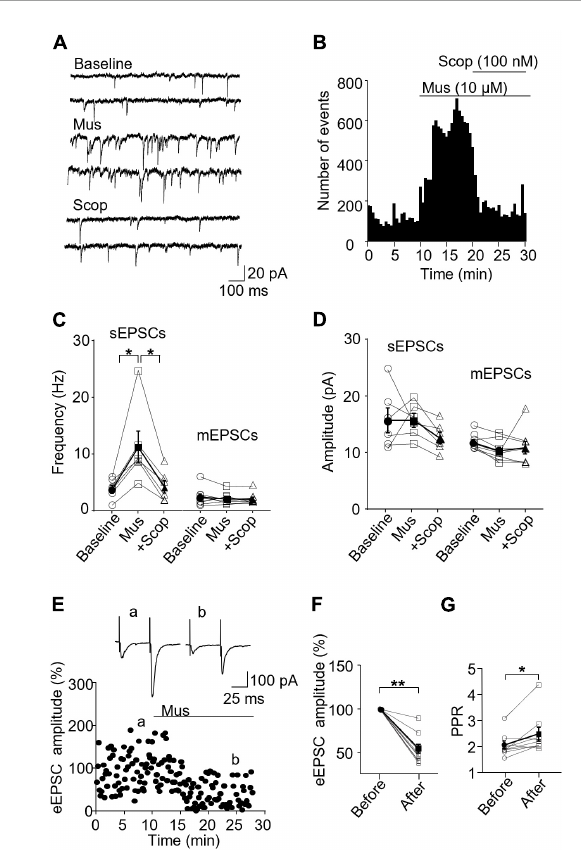
FIGURE2 Activation of mAChRs enhances spontaneous excitatory synaptic activity in SST interneurons in the ACC. (A) Representative traces of sEPSCs from an SST interneuron in the ACC before and after application of muscarine (Mus, 10 µ M) and subsequent addition of scopolamine (Scop, 100 nM). (B) A histogram from an SST interneuron shows the effect of bath application of muscarine and subsequent addition of scopolamine on sEPSC frequency. (C,D) Summarized data show the effect of muscarine on sEPSC ( n = 6 cells/6 mice) and mEPSC ( n = 6 cells/3 mice) frequency and amplitude, respectively. (E) A representative experiment shows the effect of muscarine on evoked EPSCs ( n = 9 cells/6 mice). Insets: evoked EPSCs traces taken at the times marked by a and b in the graph. (F,G) Summarized data show the effect of muscarine on evoked EPSC amplitude and the paired-pulse ratio, respectively (PPR, the 2nd EPSC/the 1st EPSC in amplitude). * p < 0.05, **p < 0.01. Mus, muscarine; Scop, scopolamine.